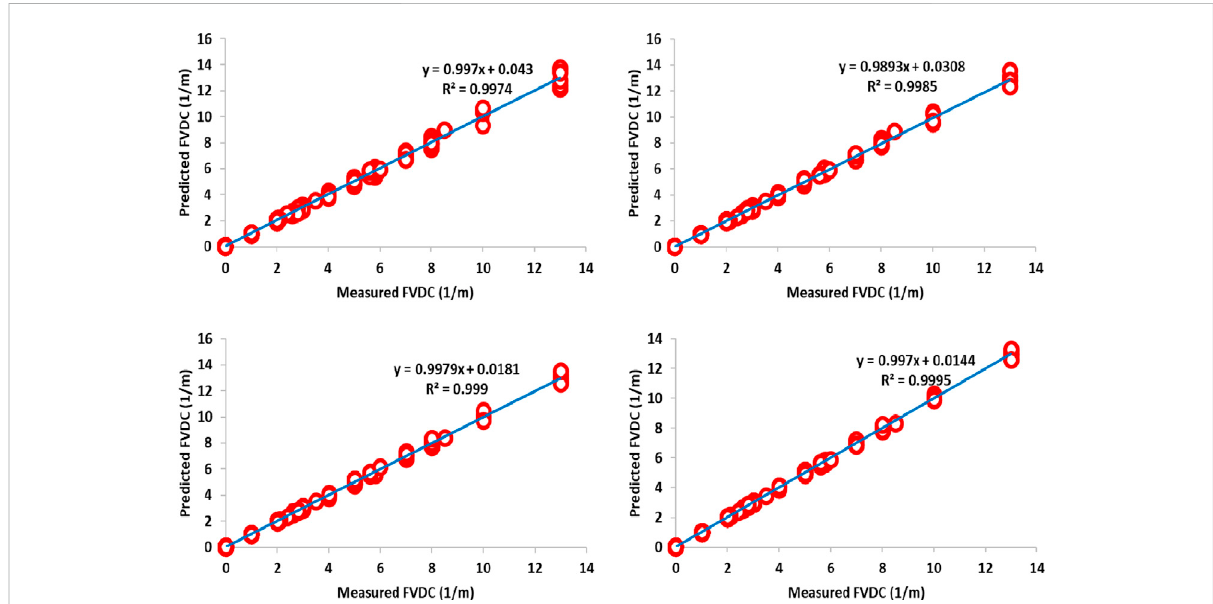
FIGURE 12 llustration of cross plot for training subset (70% ~ 2049 data point) based on four roboust hybrid machine learning LSSVM-PSO, LSSVM-GA, MLP-PSO and MLP-GA based on dataset of well #W1.